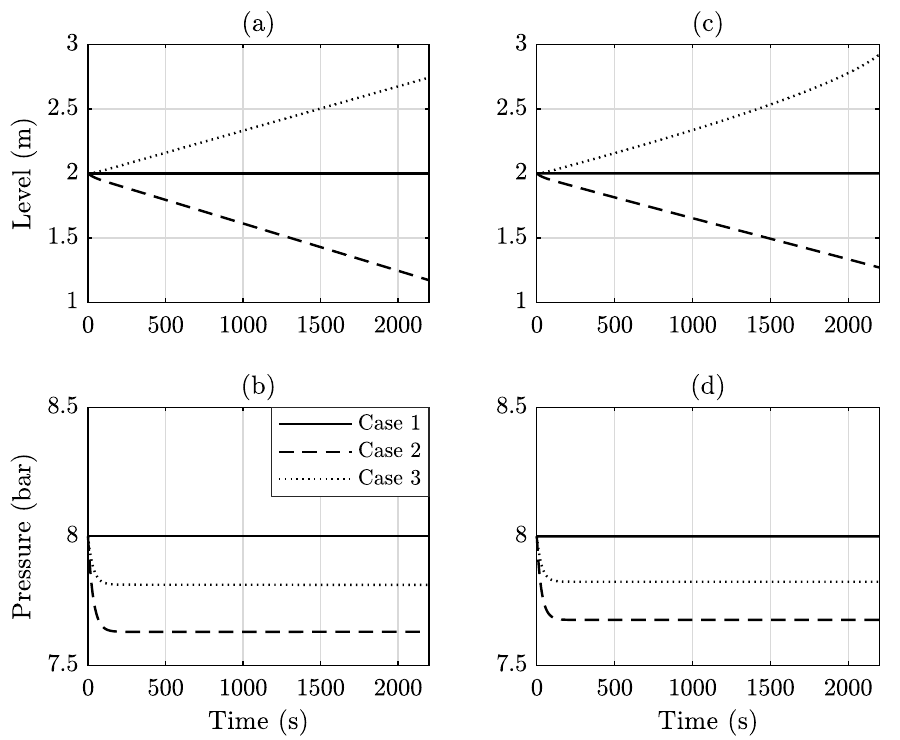
Figure 4. Simulation of the linear and nonlinear plants for different valve openings. ( a , b ) the results for the linear plant; ( c , d ) the behaviour for the nonlinear